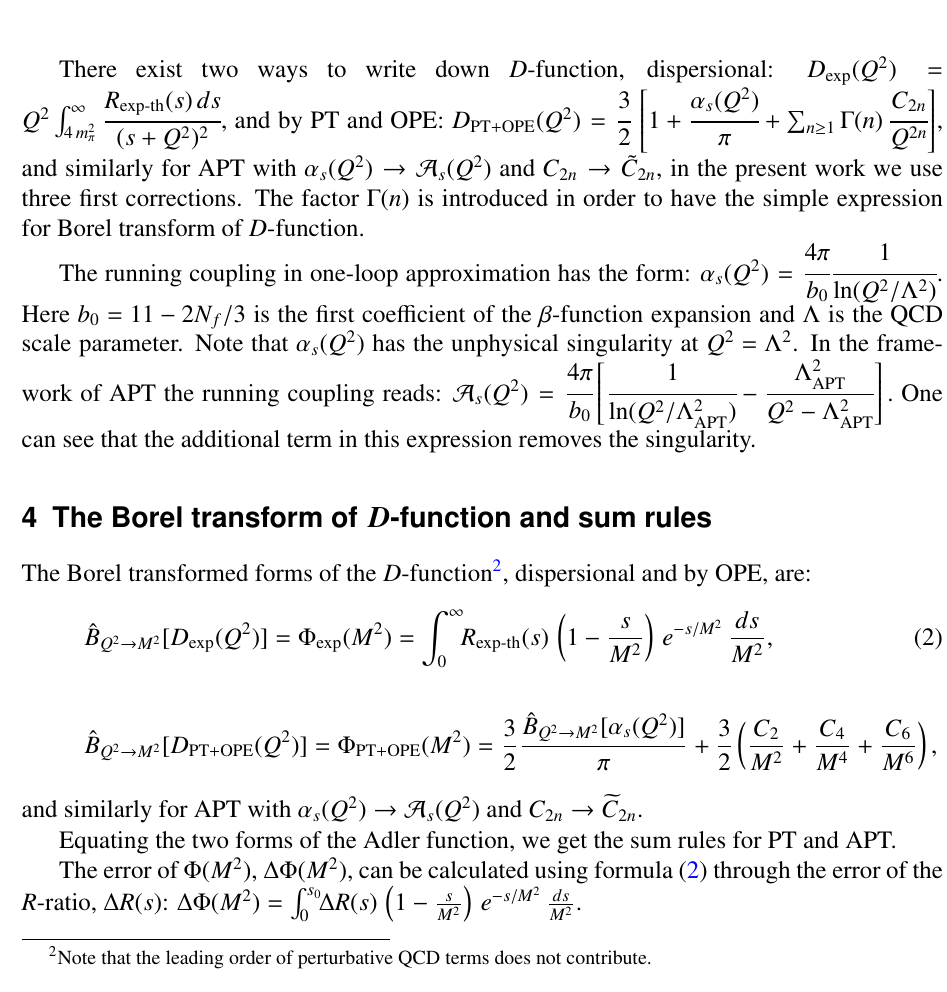
Figure 1. The full R -ratio ( R exp ) in dependence on (blue dots), the theoretical representation R th ( s ) in the PT (red, dashed) and in the APT (blue, dashed). s 0 ≈ 1 . 54 2 GeV